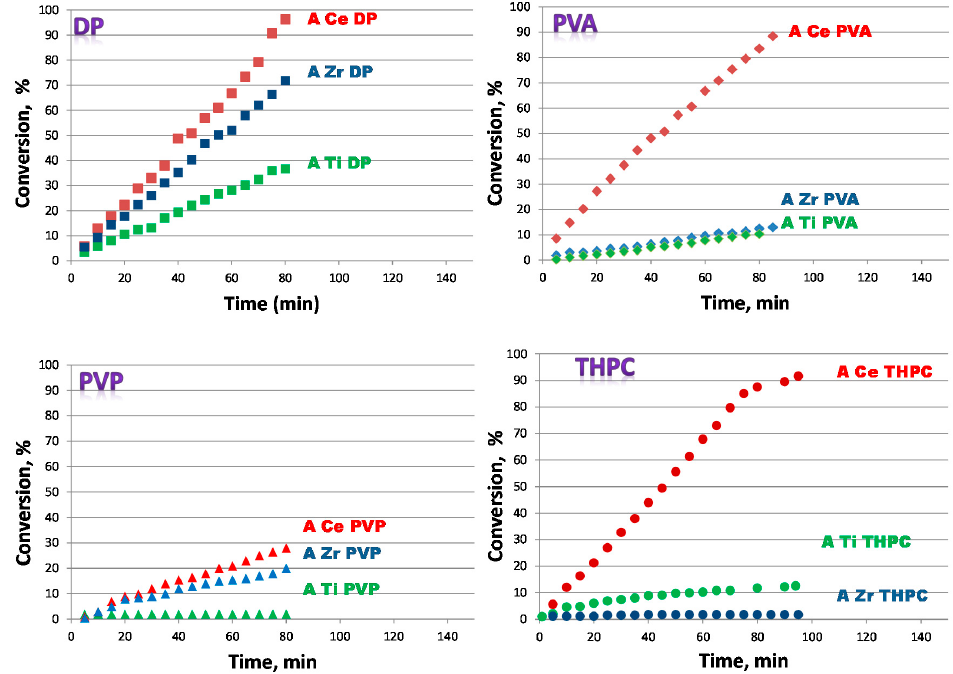
Figure 3. Conversions vs. time of reaction for D -glucose oxidation at 60 ˝ C and 100 cc/min of O 2 for samples synthesized by DP, PVA, PVP and